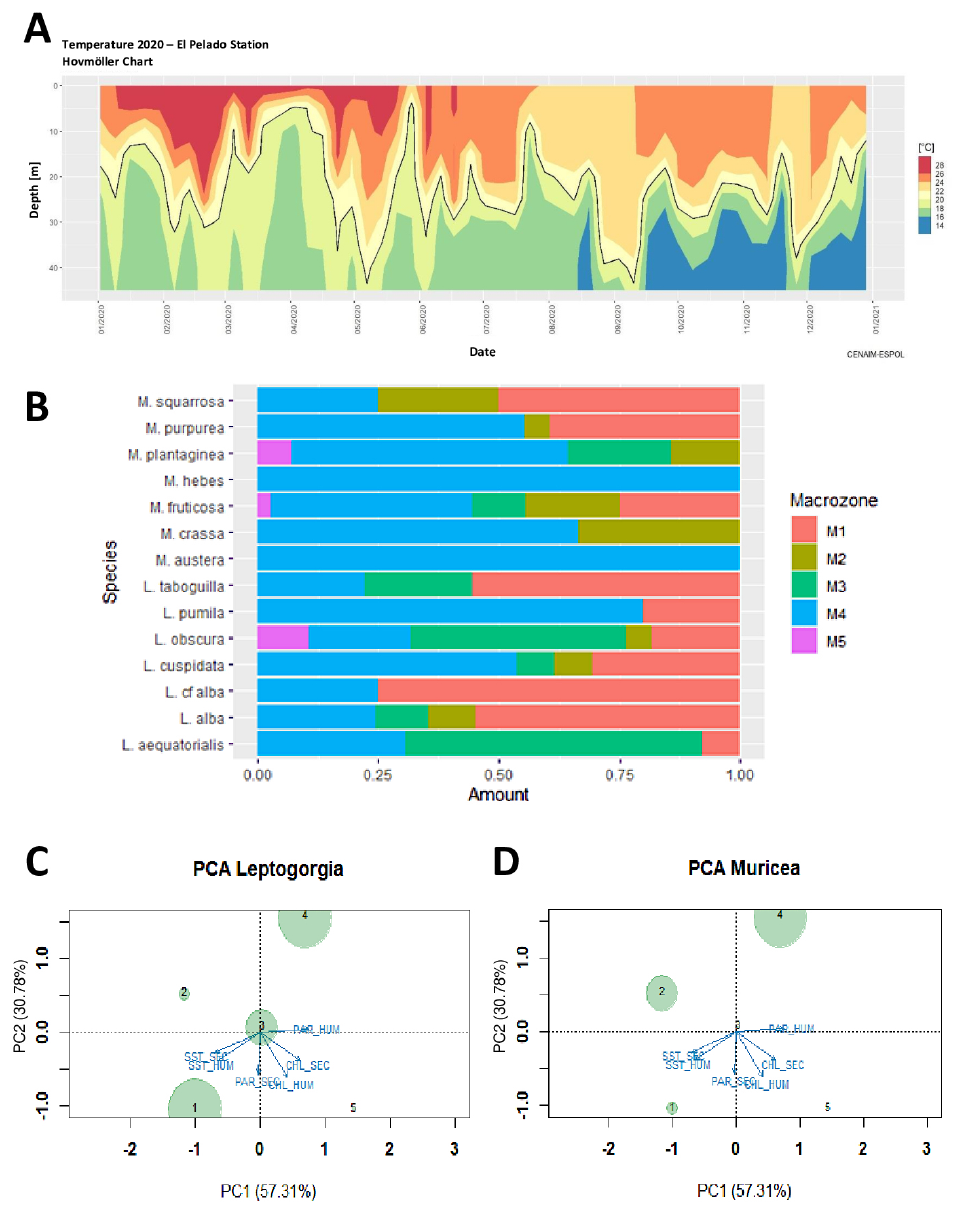
Figure 3. ( A ) Annual variation of the thermocline depth (isotherm 20 ◦ C) at the oceanographic station of CENAIM in REMAPE (Hövmoller diagram). Months are represented on the X -axis and the depths of the water column on the Y -axis. The intense red colors indicate warmer temperatures (26–28 ◦ C), and the blue areas show the coldest temperatures (16–18 ◦ C) in 2020. Source: In situ oceanographic data from the oceanographic station “El Pelado”. ( B ) Bar chart representing the cumulative amount (%) of each species in the five macrozones determined in the study. Principal Component Analysis (PCA) biplot showing sites and environmental variables associated with octocoral abundance in the EF. The length and angle of the lines show the degree of correlation of the environmental variables with PCA axes. The environmental variables are represented for both seasons. Green circles indicate the abundance of specimens in each macrozone for ( C ) Leptogorgia and ( D ) Muricea